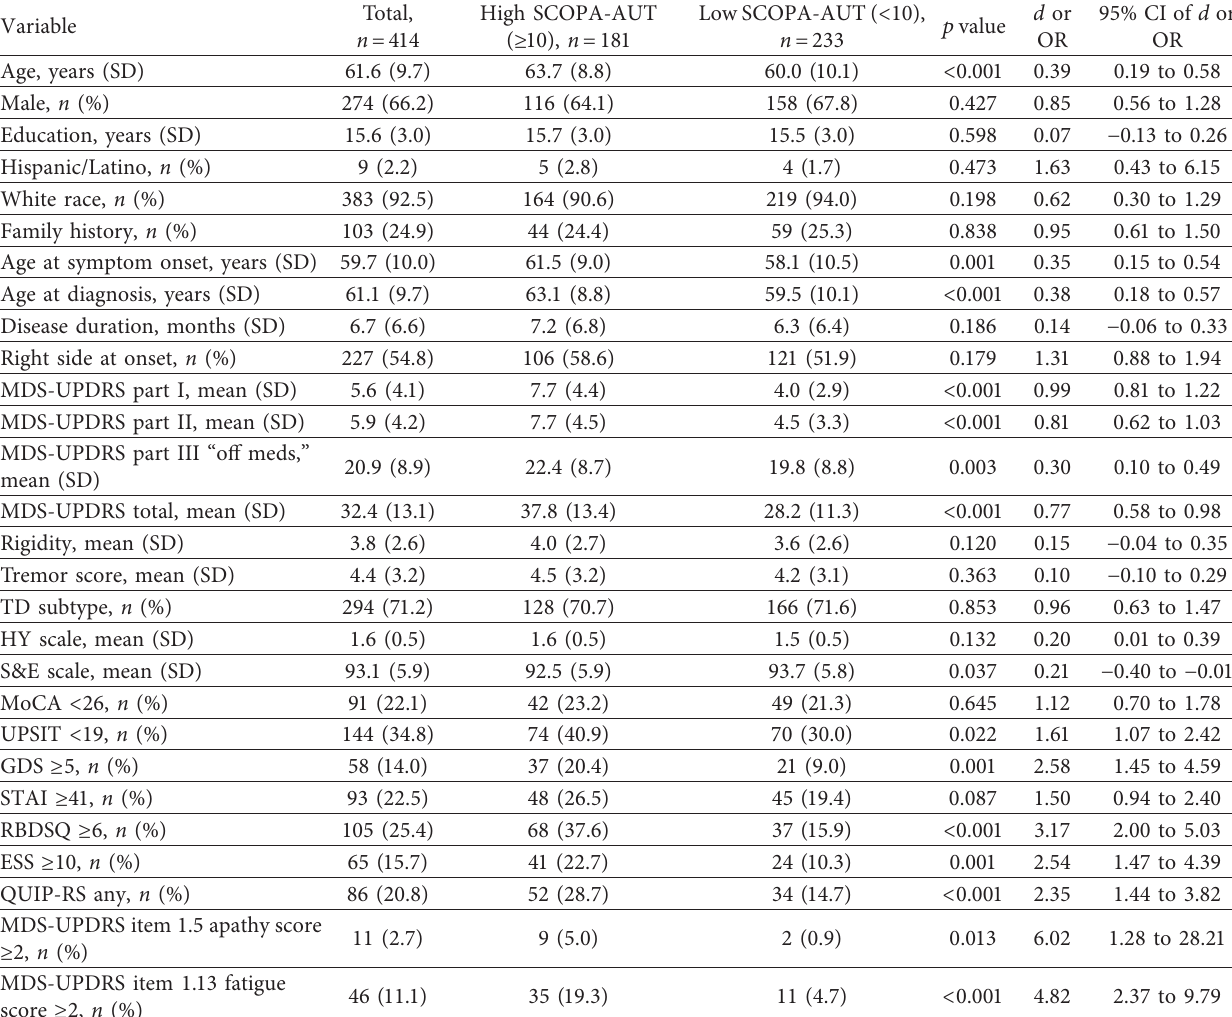
Table 2: Comparison of demographic and clinical characteristics between the low and high SCOPA-AUT score groups of patients with early